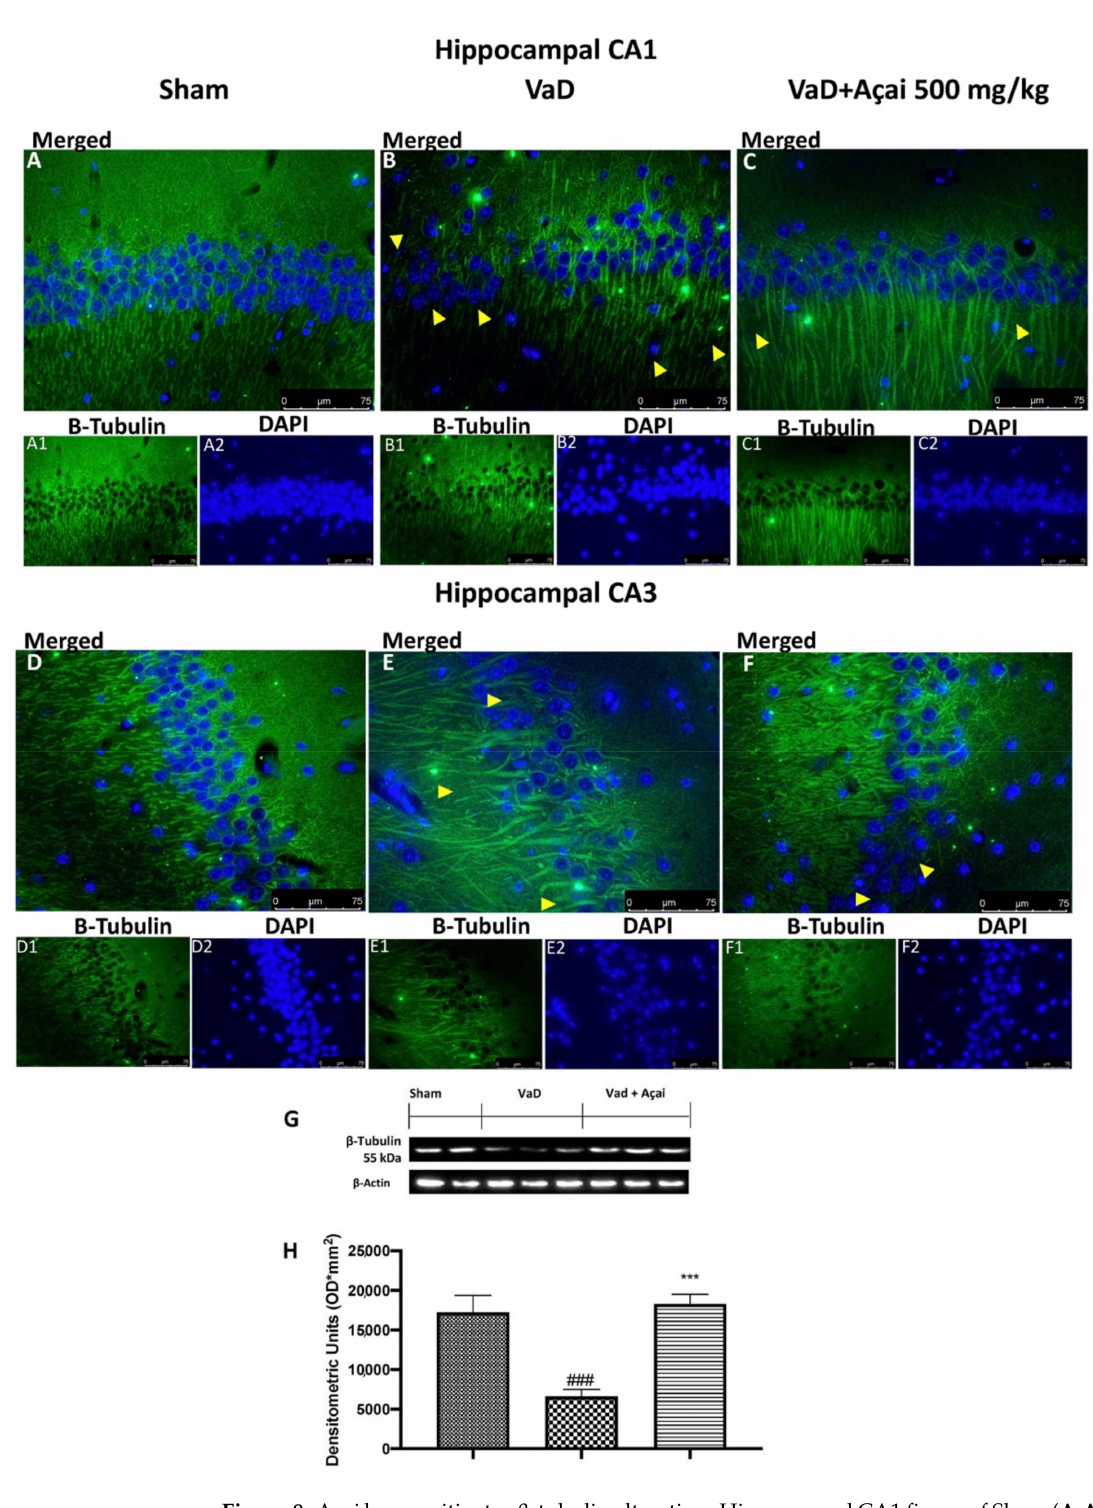
Figure 8. Açai berry mitigates β -tubulin alteration. Hippocampal CA1 figure of Sham ( A , A1 , A2 ), VaD ( B , B1 , B2 ), Açai Berry ( C , C1 , C2 ); Hippocampal CA3 figure of Sham ( D , D1 , D2 ), VaD ( E , E1 , E2 ), Açai Berry ( F , F1 , F2 ); β -tubulin western blot ( G ) and relative densitometric analysis ( H ). Arrows indicate the alteration or absence of β -tubulin. Values are means ± SEM of six mice for all groups. Figures are representative from at least three experiments. See manuscript for further details. *** p < 0.001 vs. sham; ### p < 0.001 vs.